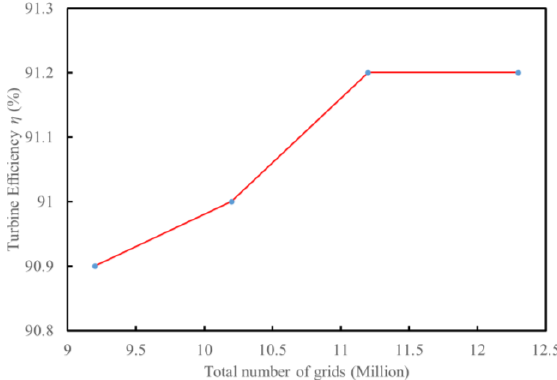
Figure 3. Efficiency of turbine with different grid numbers.